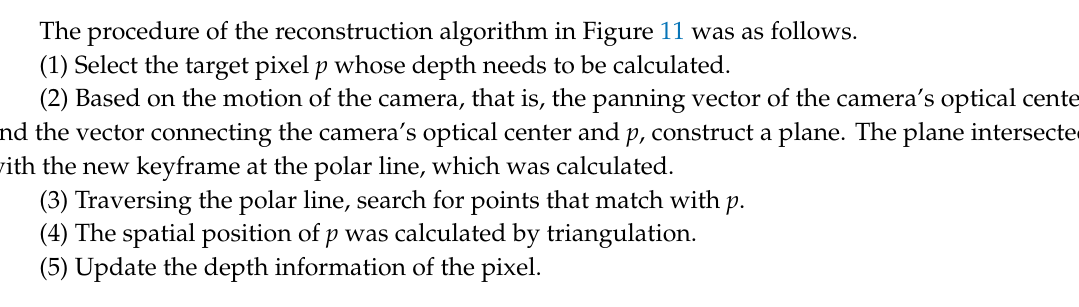
Figure 11. Flowchart of the reconstruction module of the visual SLAM algorithm.